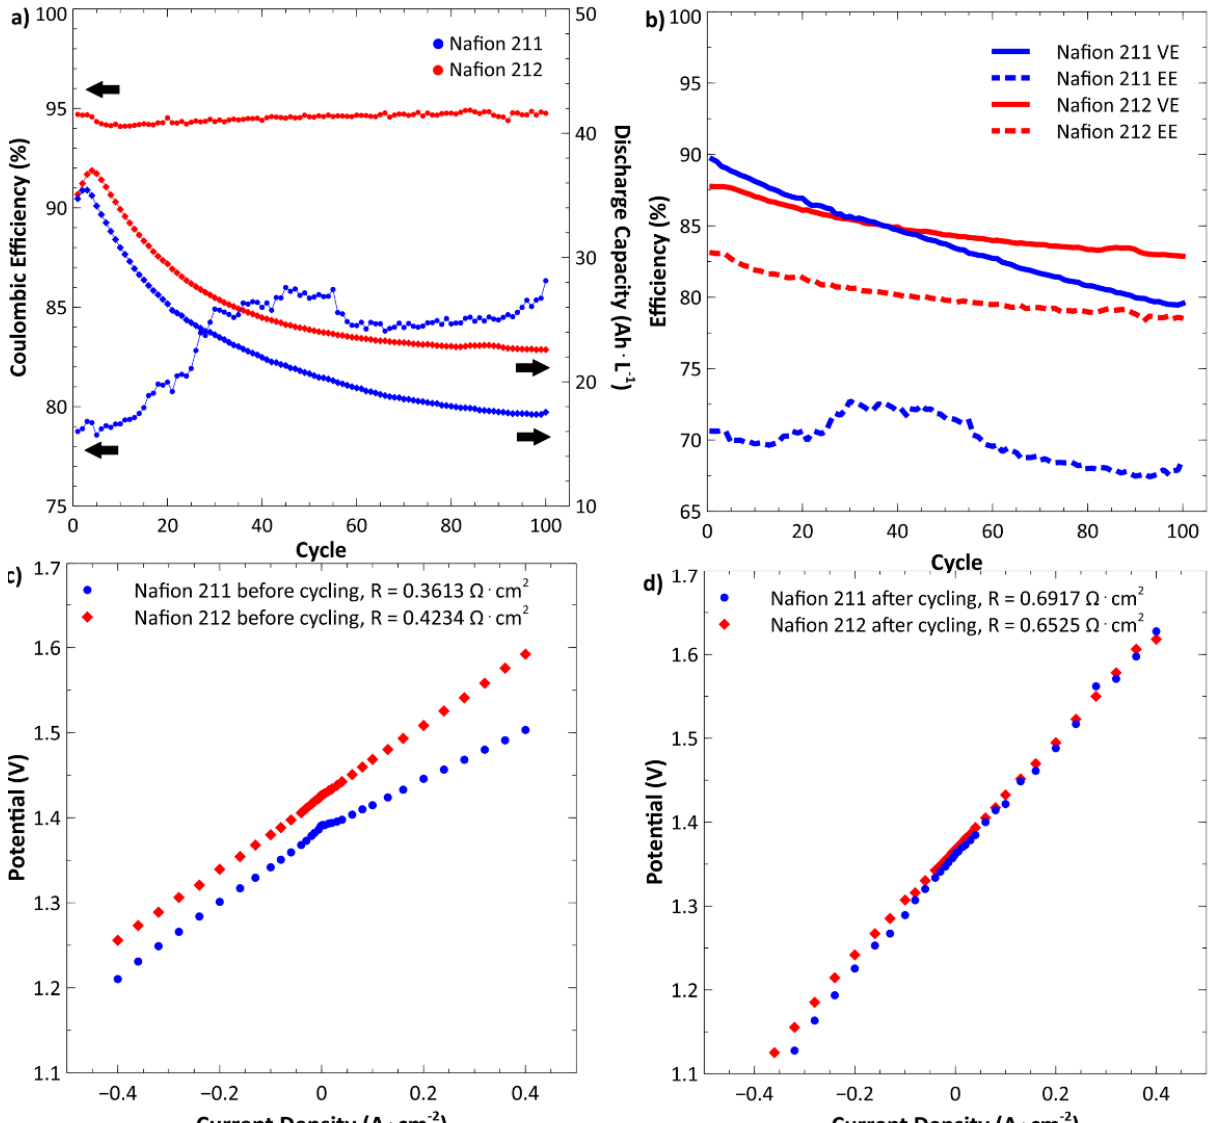
Figure 2. Charge/Discharge performance of the VRFB cell for Nafion 211 and 212 membranes over 100 cycles showing ( a ) Coulombic Efficiency and Discharge Capacity, ( b ) Voltage and Energy Efficiency, ( c ) Polarization curves prior to cycling, ( d ) Polarization curves after cycling. Experimental conditions: 1.6 M V(III) negative electrolyte, 1.6 M V(IV) positive electrolyte, both in 2 M H 2 SO 4 supporting electrolyte, constant current charging at 200 mA cm − 2 , 200 rpm flow rate and room temper- ature.